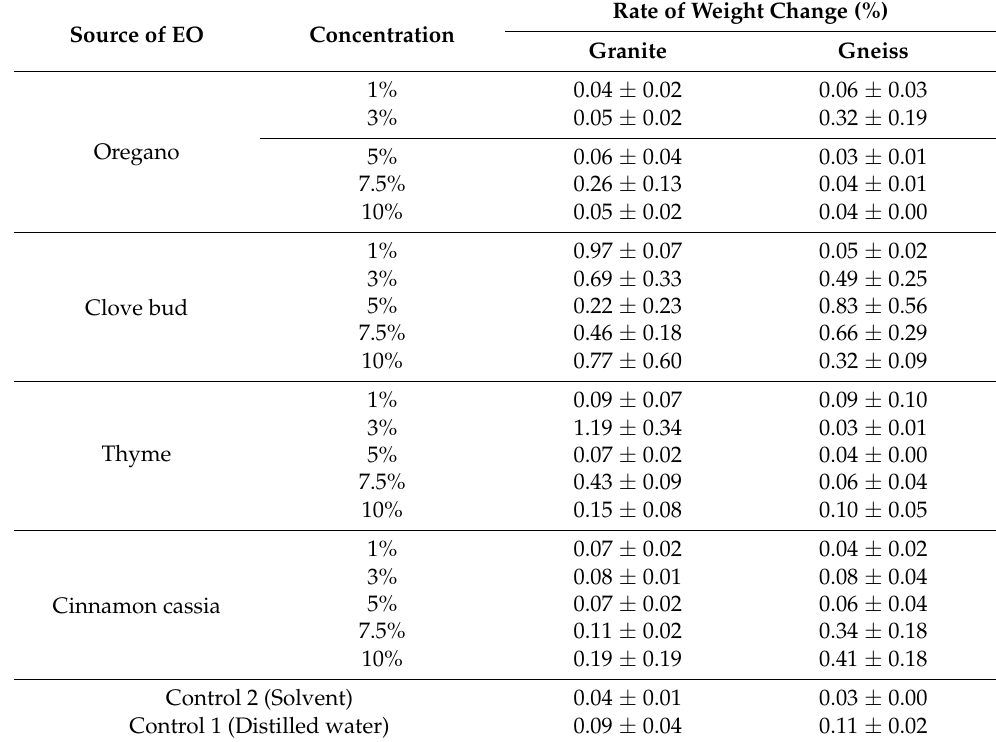
Table 4. Rates of weight change for the granite and gneiss specimens before and after treatment with low-concentration essential oils. Source of EO Concentration